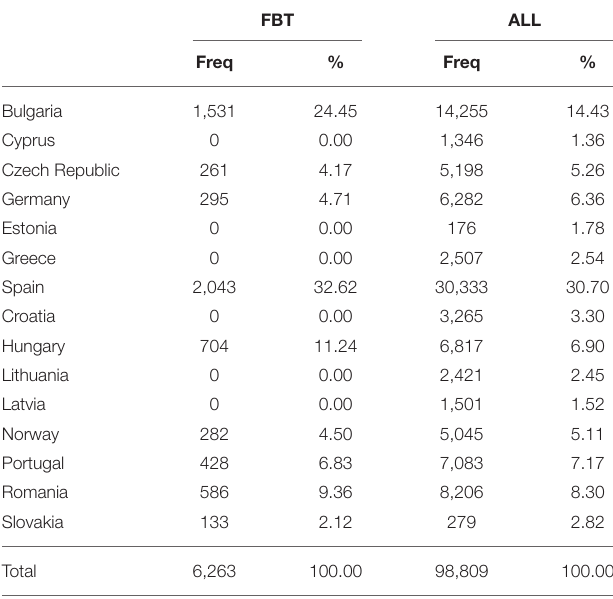
TABLE 2 | Number of foods, beverages, and tobacco enterprises from EU countries that participated in the